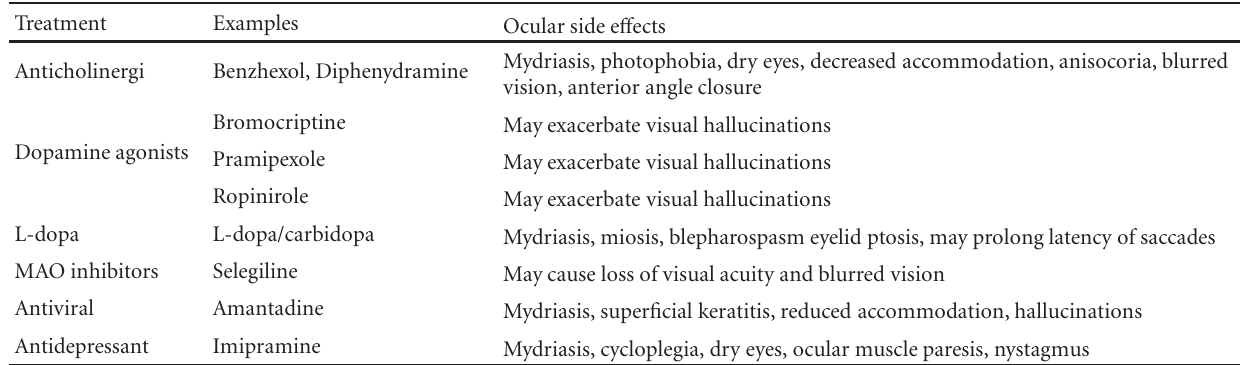
Table 2: Adverse ocular reactions to treatment for Parkinson’s